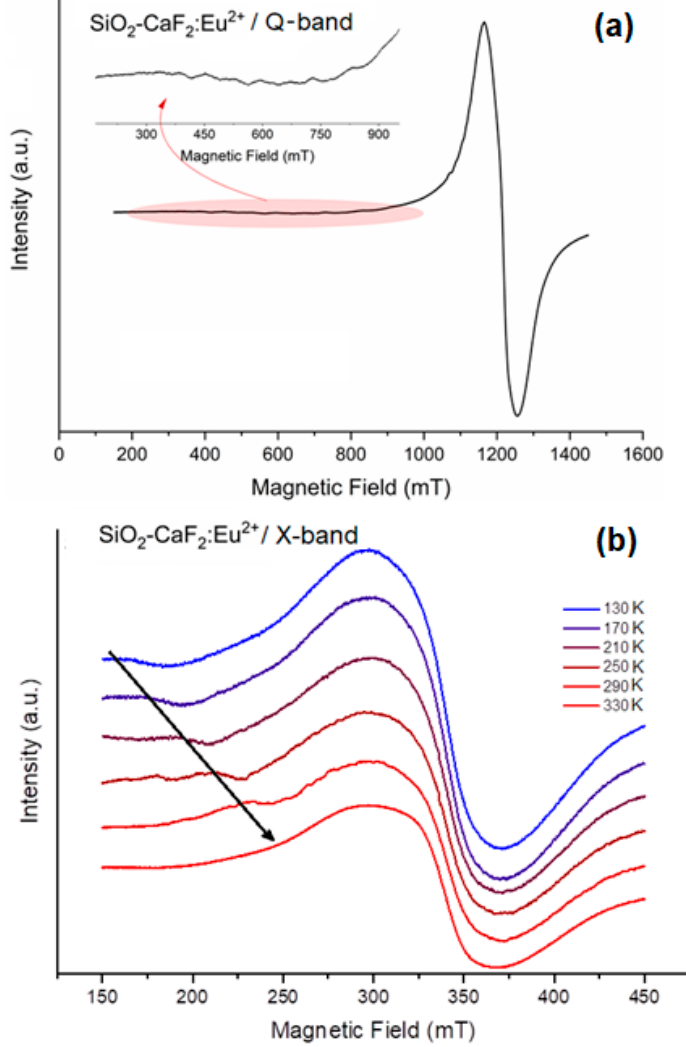
Figure 6. Q-band EPR spectrum of the Eu 2+ -doped SiO 2 -CaF 2 glass-ceramic annealed in a reducing atmosphere ( a ). The inset shows a magnification of the low-field EPR resonances. X-band EPR spectra of the Eu-doped glass-ceramic annealed in a reducing atmosphere at temperatures ranging from 130 to 330 K with 40 K steps ( b ).